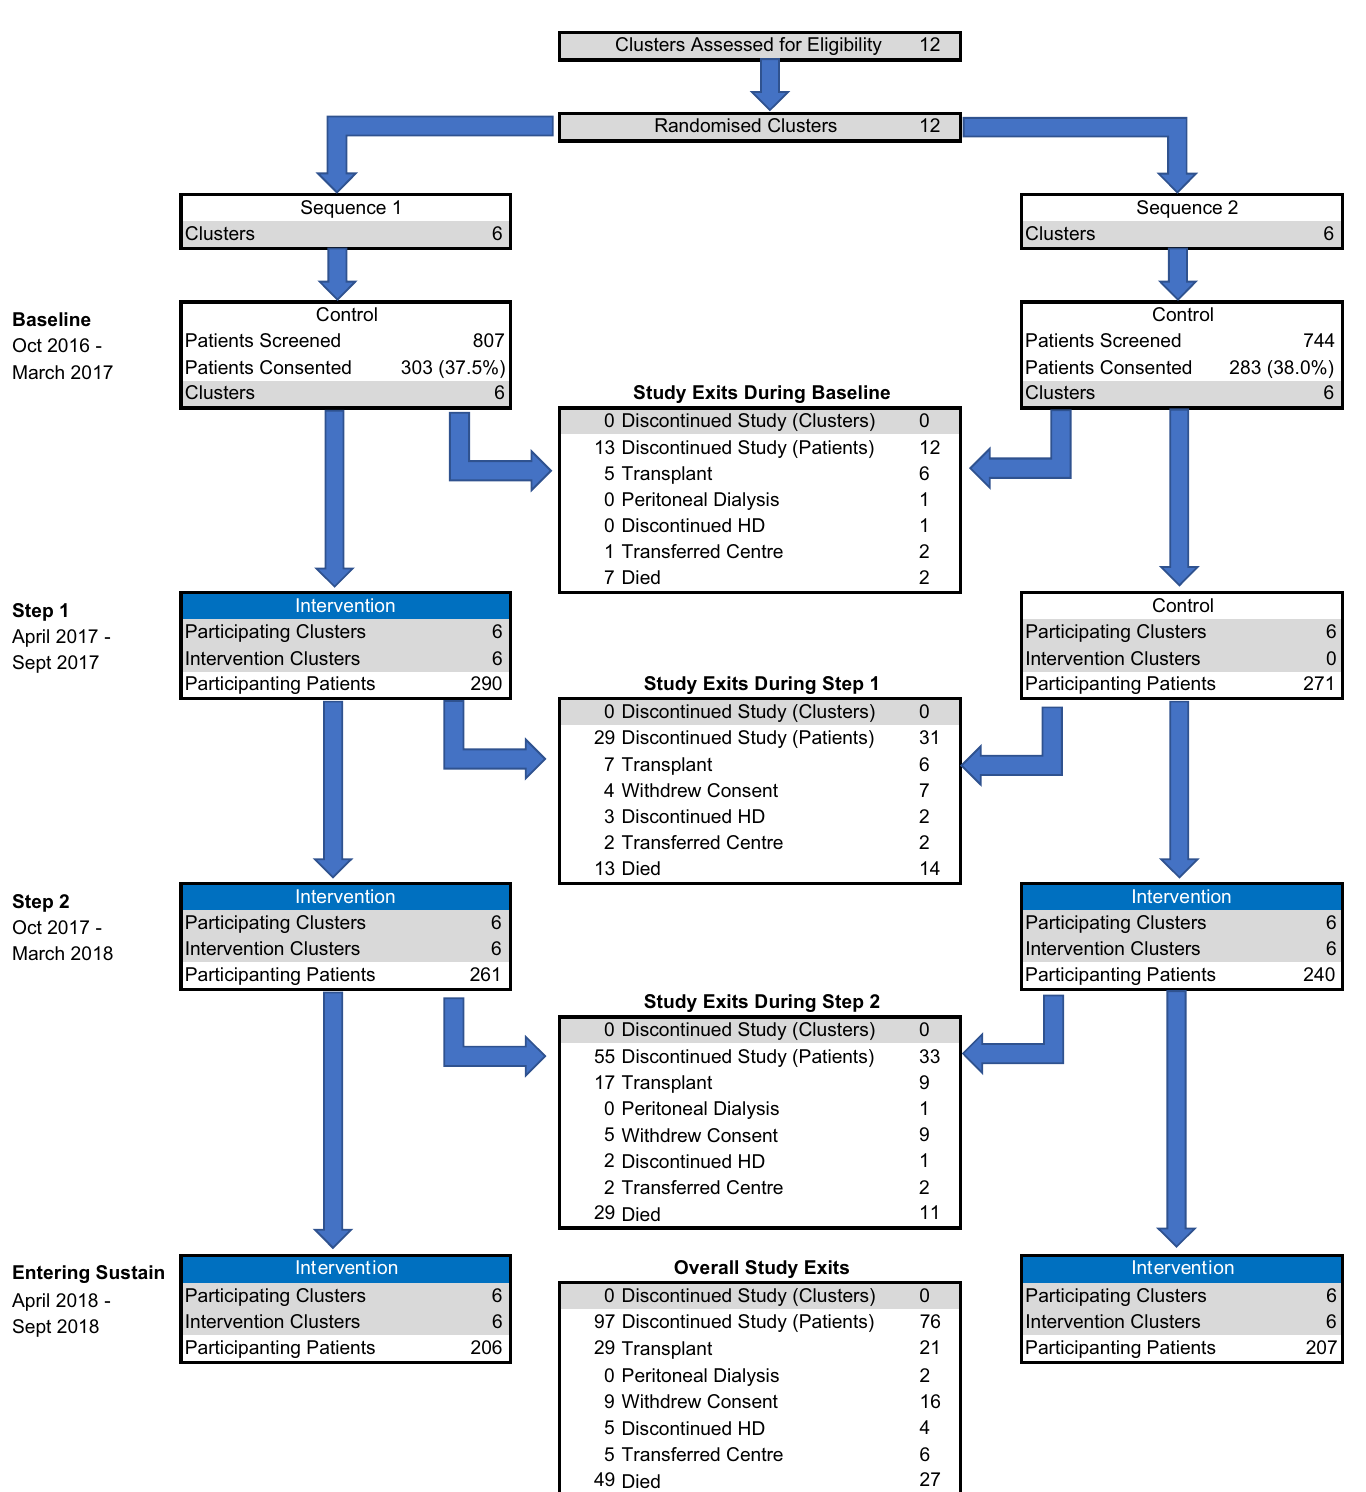
Fig 1. Study patient and cluster flow though the stepped wedge randomised controlled trial.